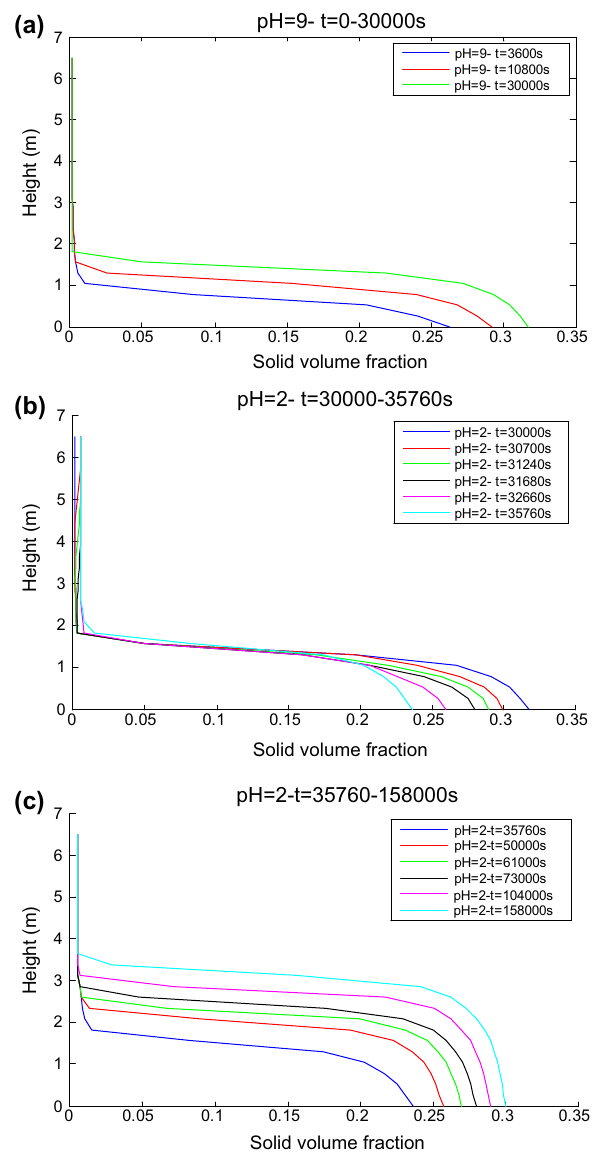
Fig. 1 The results of dynamic simulation of time-dependent varia- tions of pH of input feed to thickener for the conditions: d 80 = 275 l m, F = 40 g/t, First pH 9 and then pH